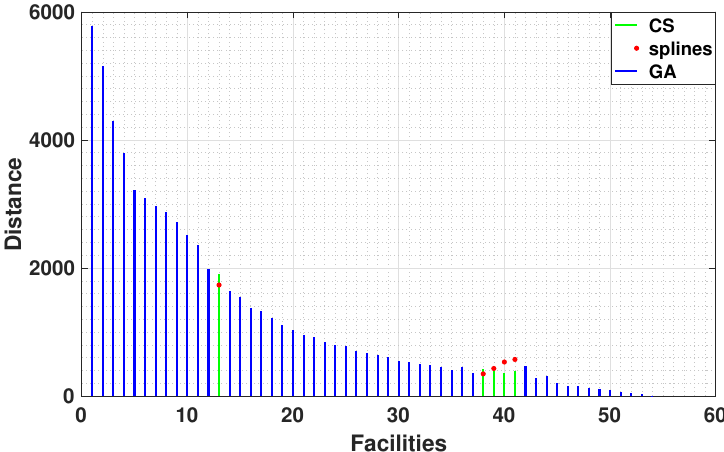
Figure 9. The Pareto set after solving the facility location problem for the Swain dataset using: genetic algorithms, crowdsourcing and cubic